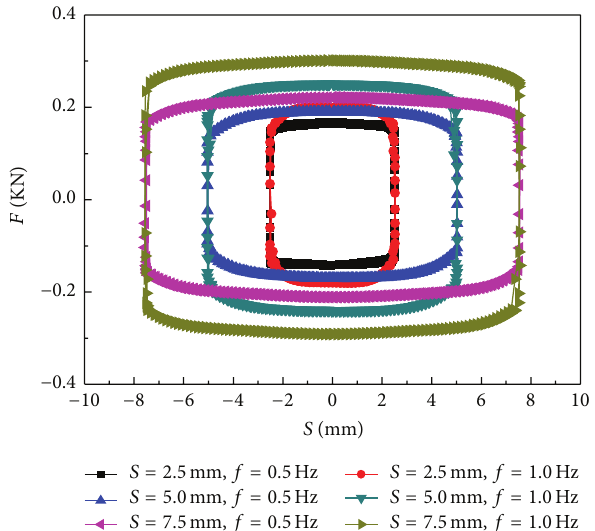
Figure 15: Damping force under different frequencies and different displacements.